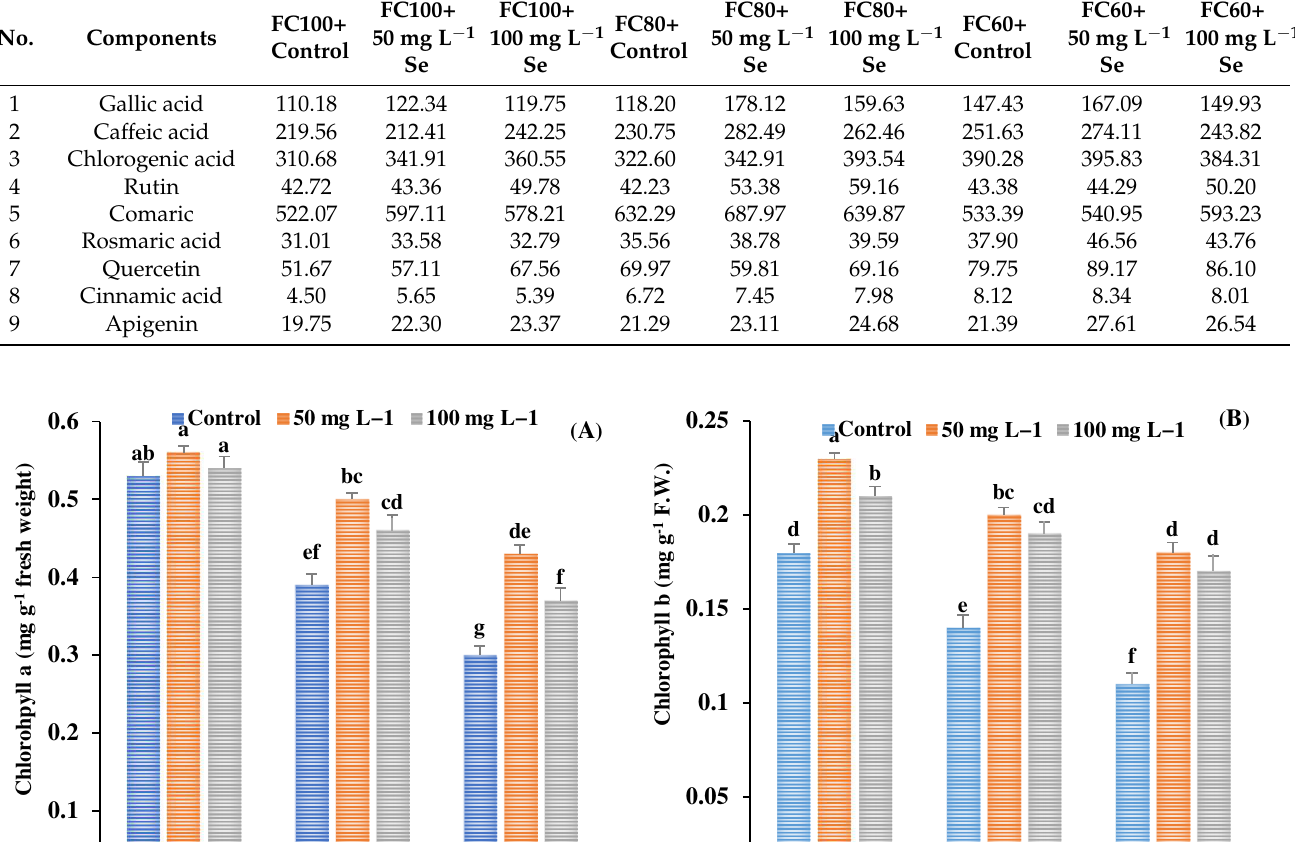
Table 4. The phenolic compounds of basil in different irrigation regimes and Se NPs. ppm